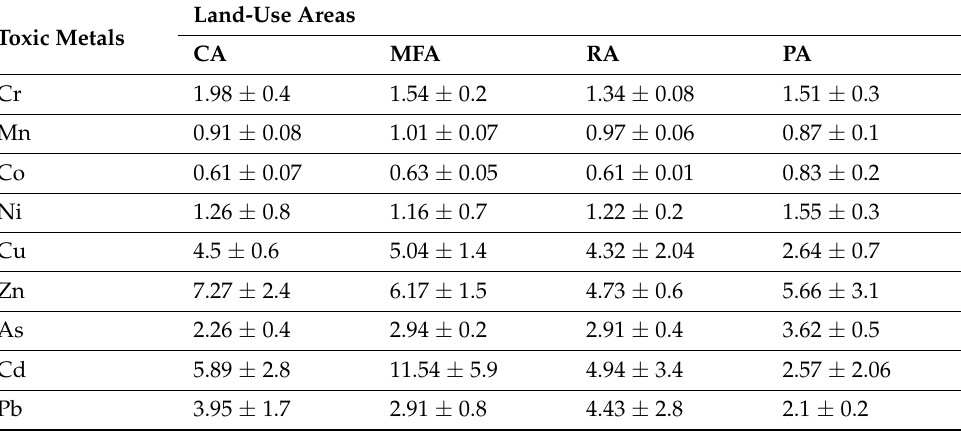
Table 2. Enrichment factor (EF) of toxic metals in road dust at different land use areas in Mymensingh